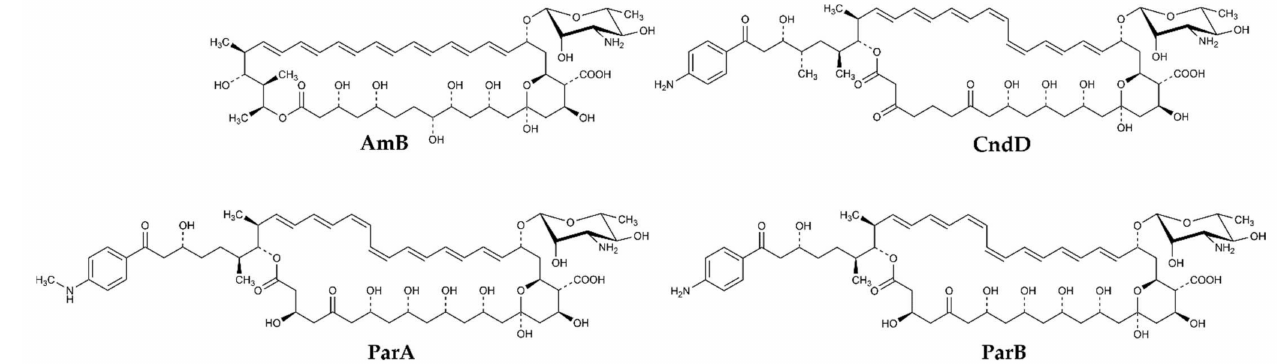
Figure 1. Structures of heptaene macrolide antifungal antibiotics studied in this work; AmB (Amphotericin B), CndD (Candicidin D), ParA (Partricin A), ParB (Partricin